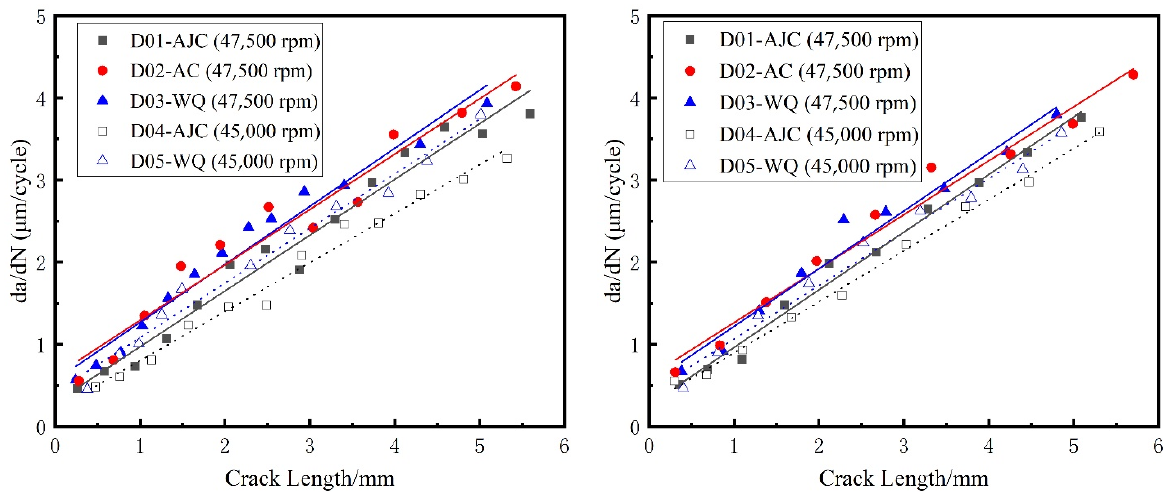
Figure 20. Inner surface crack propagation rate vs. crack length. (Path 1 on the left , path 2 on the right ).